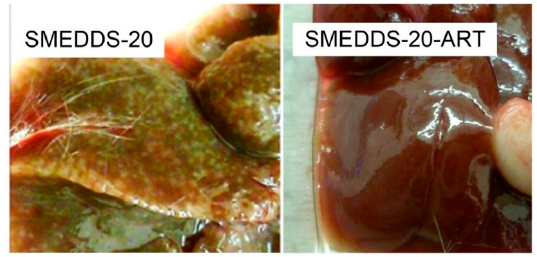
Figure 8. Gross macroscopic observation of livers of infected mice, vehicle or artemisone-treated.